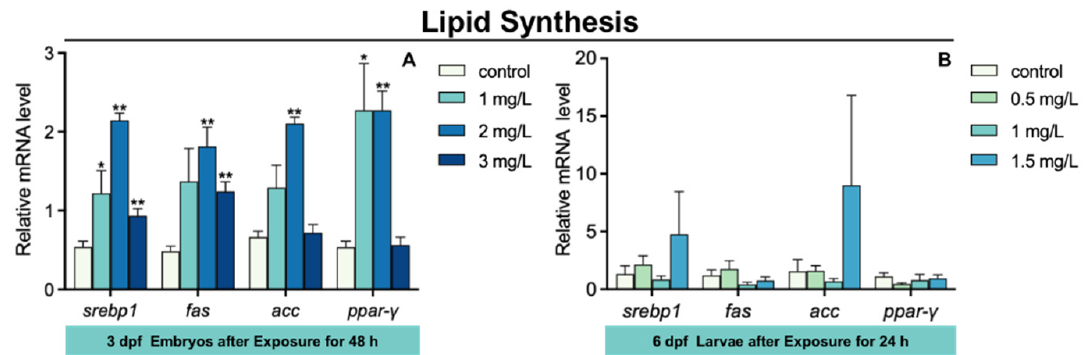
Figure 6. The expression of lipid synthesis genes (including srebp1 , fas , acc , and ppar- γ ) in zebrafish. ( A ) For 3 dpf zebrafish embryos, the expression of srebp1 , fas , acc , and ppar- γ after triflumizole exposure for 48 h. ( B ) For 6 dpf zebrafish larvae, the expression of srebp1 , fas , acc , and ppar- γ after triflumizole exposure for 48 h. Data are expressed as the mean of three replicates ± standard error (SEM). Asterisks denote significant differences between the control group and TFZ groups (determined by Dunnett post hoc comparison, * p < 0.05, ** p < 0.01). srebp1 : sterol regulatory element binding transcription protein 1; fas : fas cell surface death receptor; acc : acetyl-coa carboxylase; ppar- γ : peroxisome proliferator-activated receptor gamma.